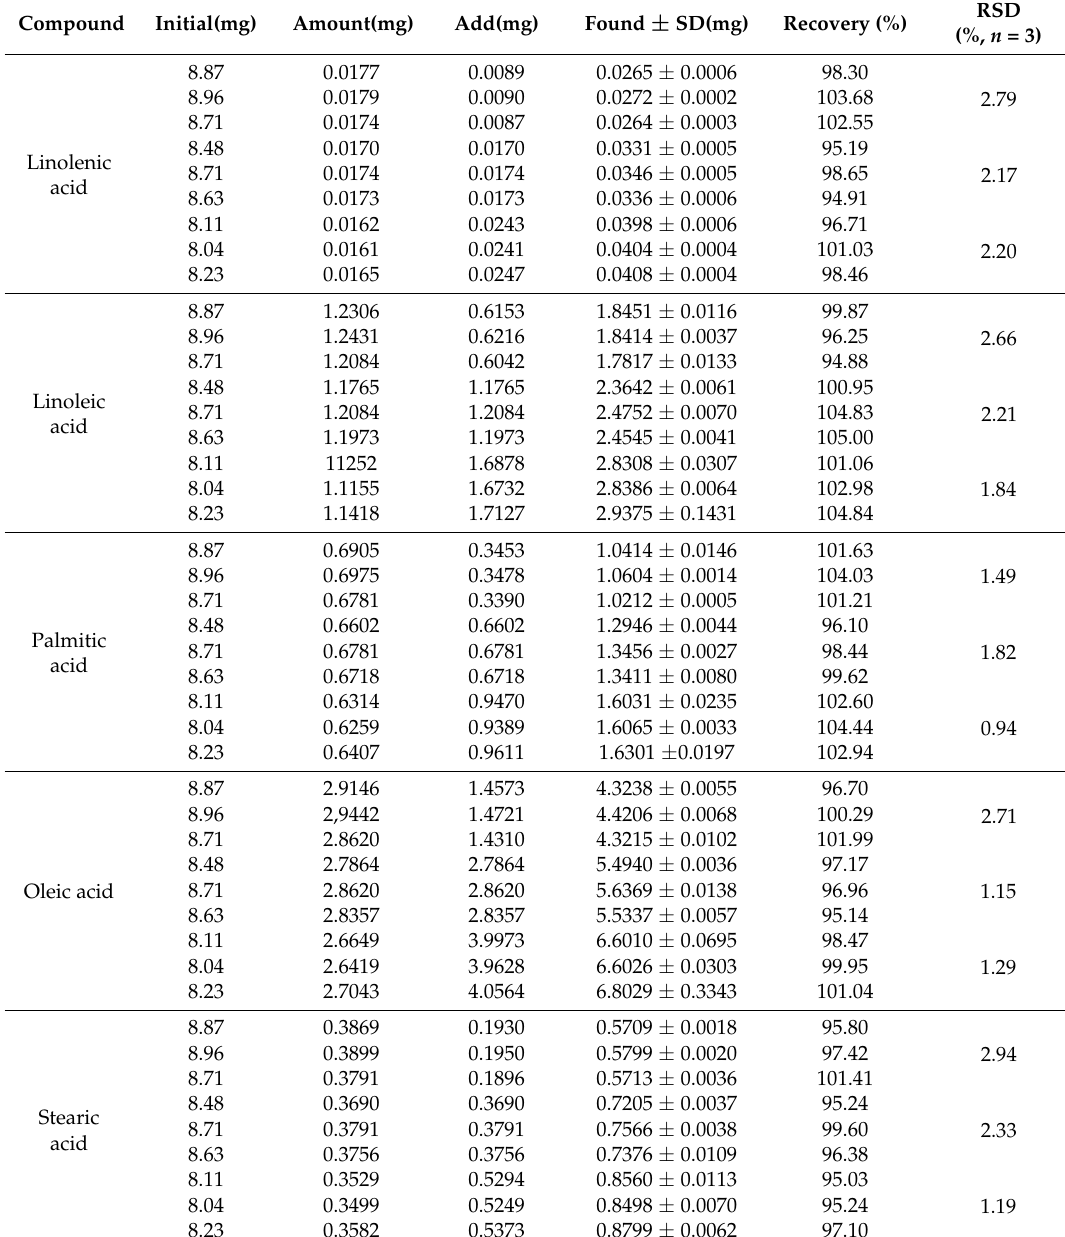
Table 3. Recovery of Five FAs in